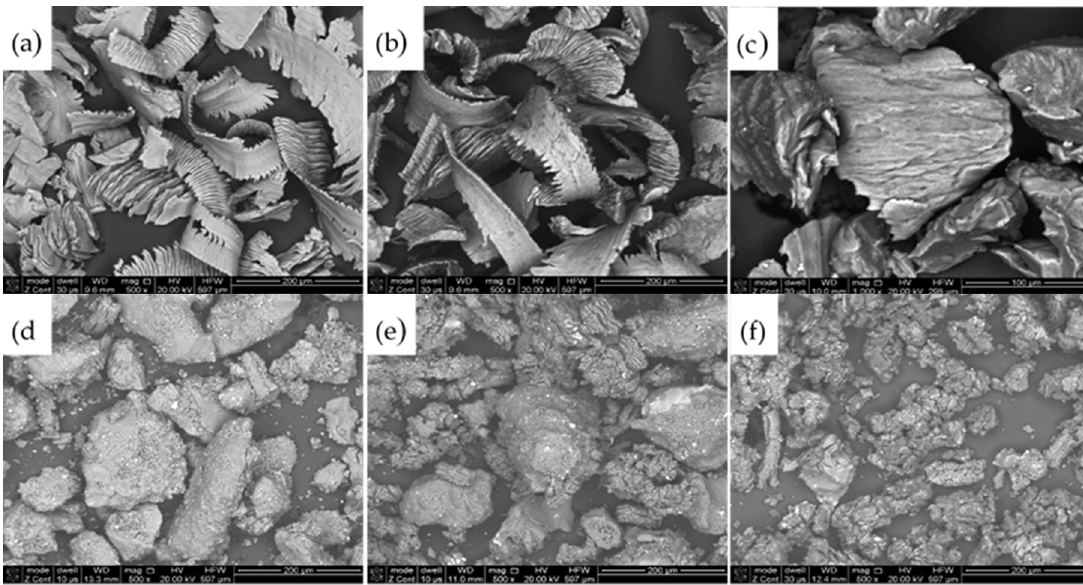
Figure 3. The morphology of chips obtained after machining the AZ31 alloy modified by 4.0 wt.% Li ( a ), 7.5 wt.% Li ( b ) and 15.0 wt.% Li ( c ), as well as ground and hydrogenated particles of AZ31 alloy modified by 4.0 wt.% Li ( d ), 7.5 wt.% Li ( e ) and 15.0 wt.% Li ( f ). Table 1. The particle size for powders with various lithium